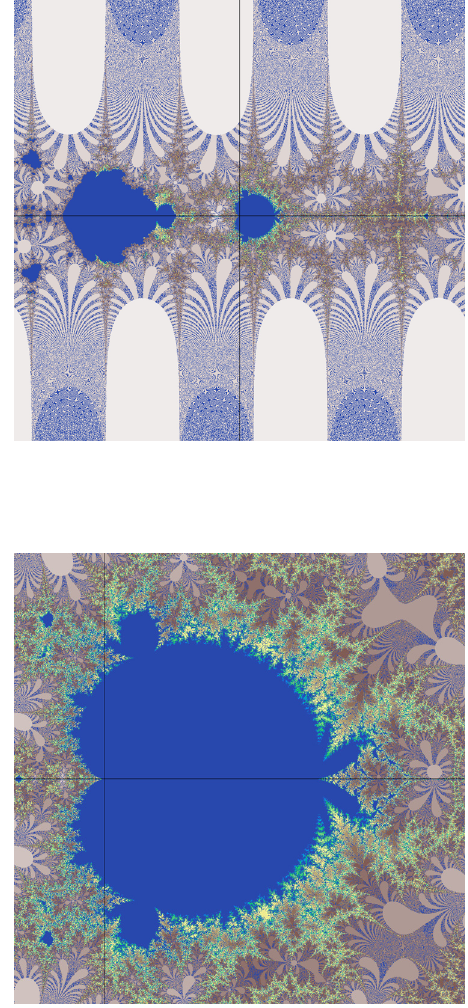
Figure 9: Close up of the “ cardioid.